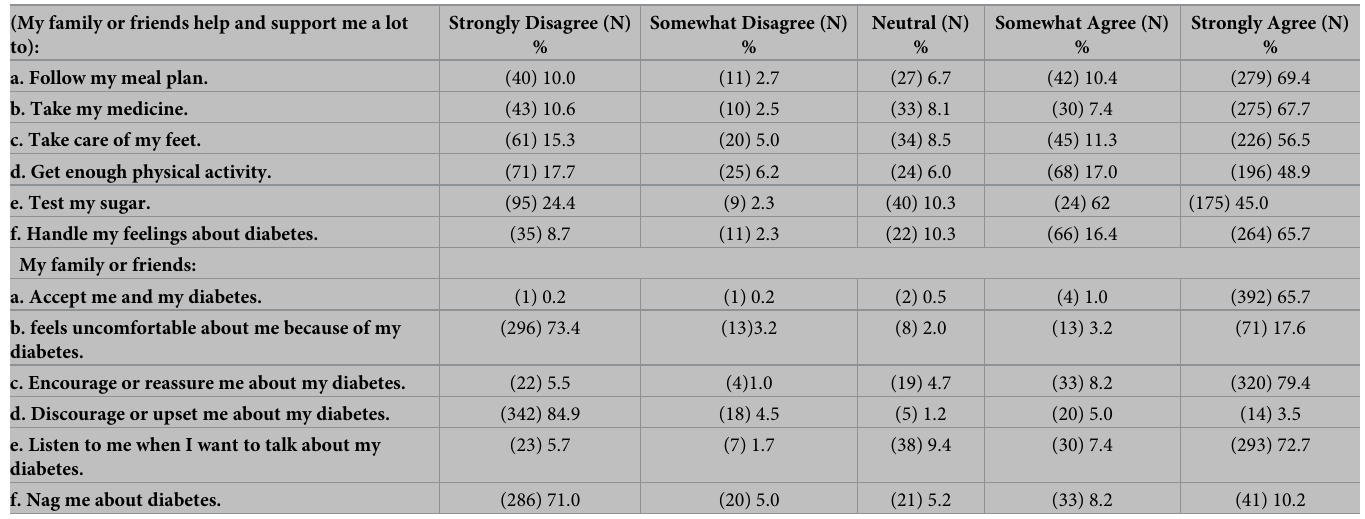
Table 4. Social support assessment of the study participants (n = 406).